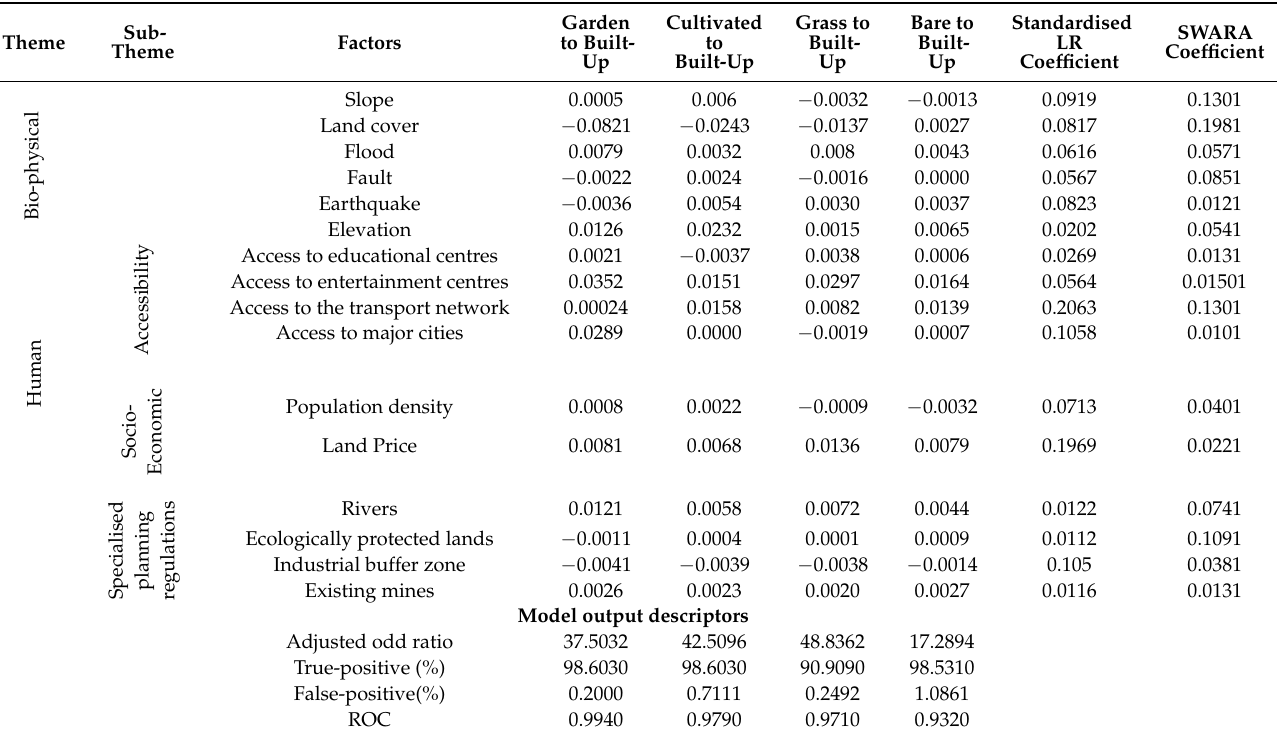
Table 5. Results of LR in estimating the potential of changing non-built-up to built-up